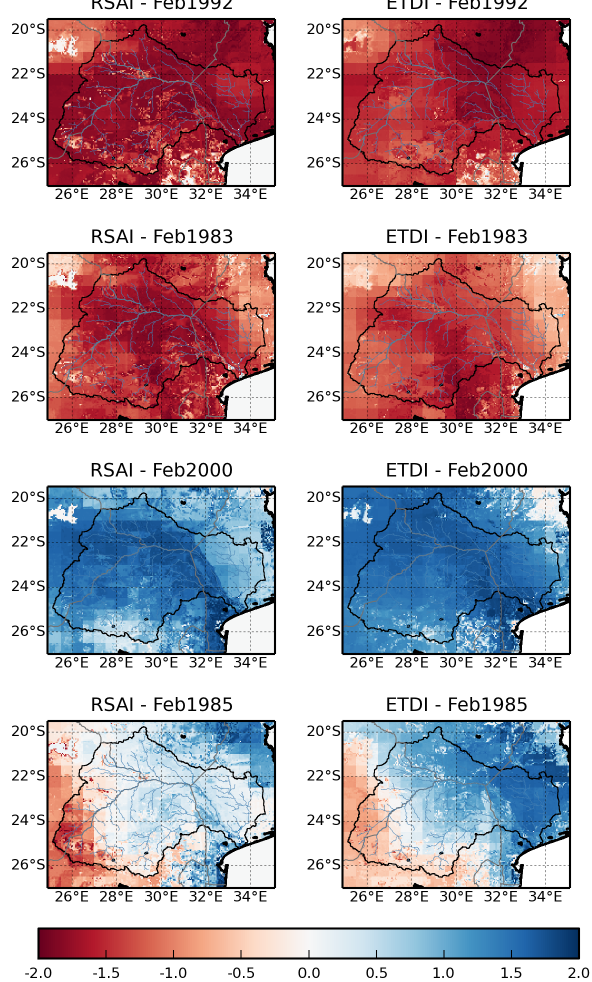
Figure 2. Root Stress Anomaly Index (RSAI) and Evapotranspira- tion Deficit Index (ETDI) in the Limpopo Basin for selected